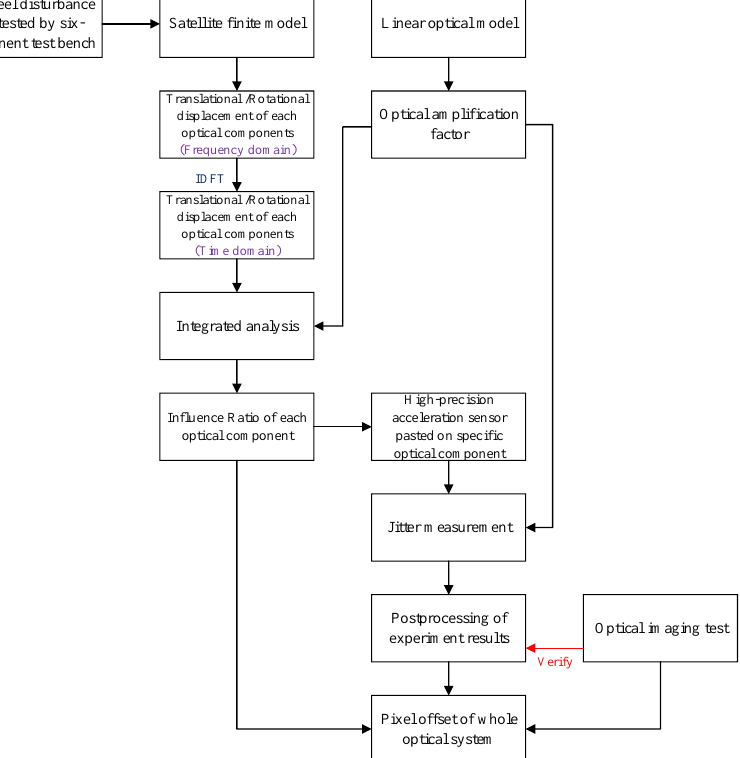
Figure 1. A flow chart showing the combination of the simulation and the experiment.